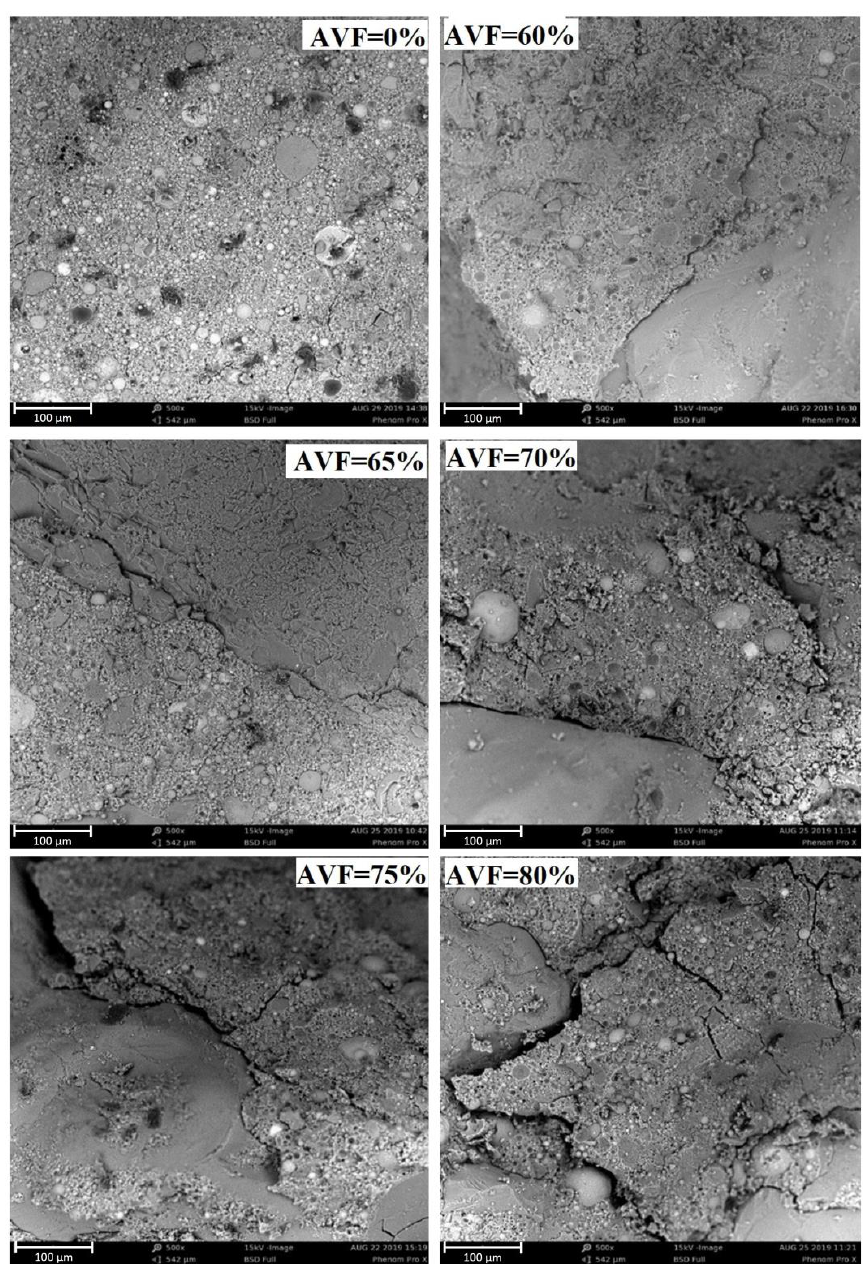
Figure 5. SEM micrographs of the geopolymer paste GC2, GC5, GC13, GC1, and GC9 mixes repre- senting AVFs of 0%, 60%, 65%, 70%, 75%, and 80%,